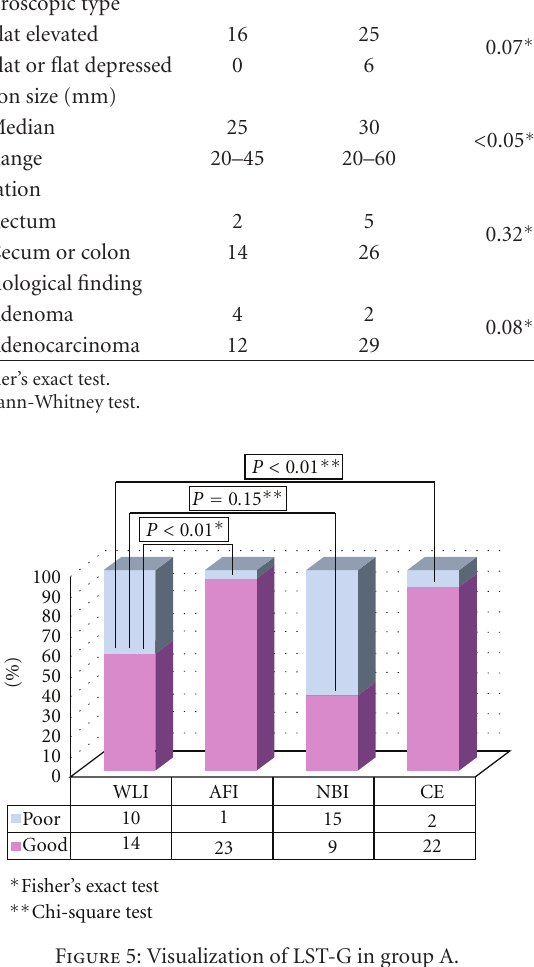
Figure 5: Visualization of LST-G in group A.